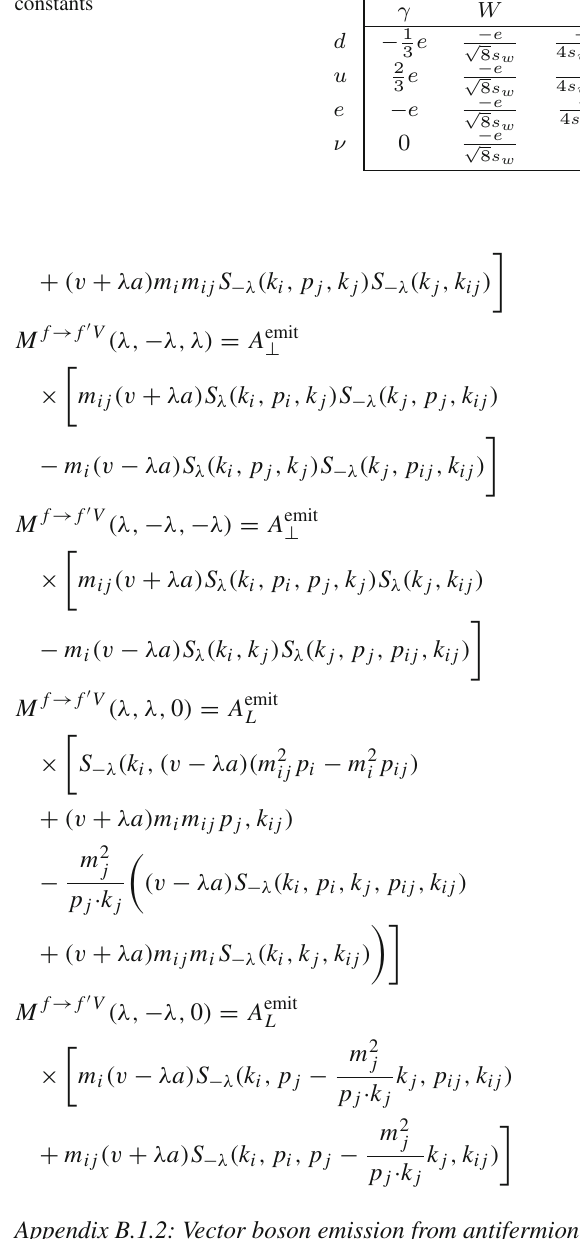
Table 8 Values of the coupling